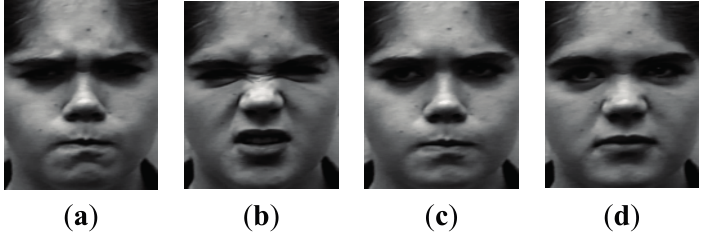
Figure 4. Anger and Disgust in different intensity ( a ) Anger in high intensity; ( b ) Disgust in high intensity; ( c ) Anger in low intensity; ( d ) Disgust in low